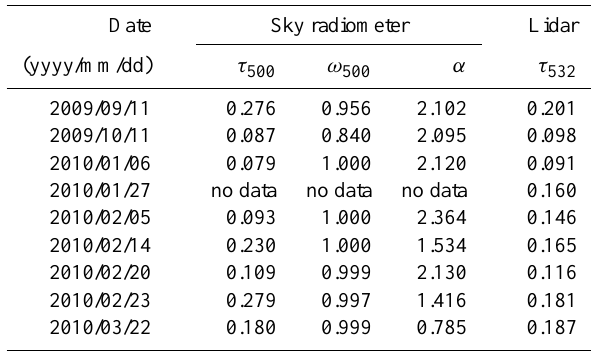
Table 4. Optical thickness at 500nm ( τ 500 ) , single-scattering albedo at 500nm ( ω 500 ) , and Angstrom exponent ( α) observed by sky radiometer, and aerosol optical thickness at 532nm ( τ 532 ) de- termined by lidar at